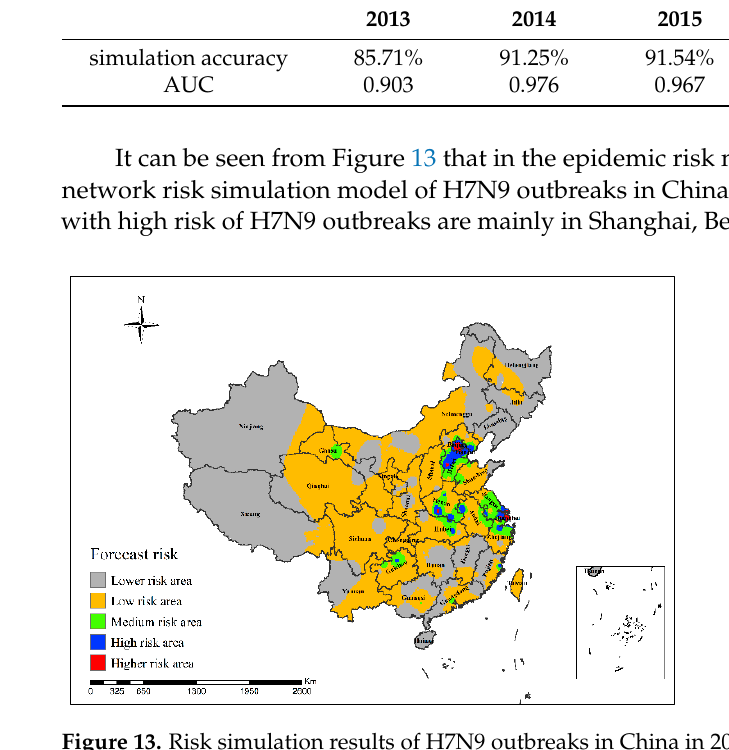
Table 3. Simulation results of the neural network risk simulation model of H7N9 outbreaks in China.